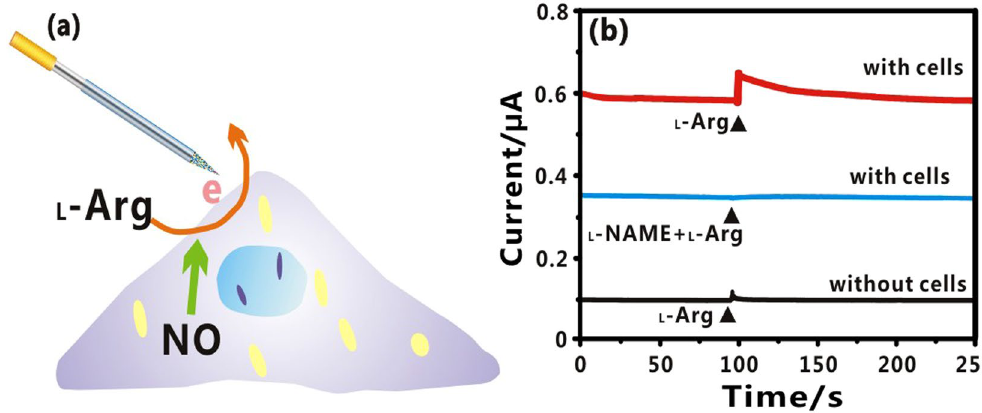
Figure 4. ( a ) Schematic illustration of the functionalized needle for real-time monitoring of NO release from living cell. ( b ) Amperometric response of the FGPC/AN to NO at cell